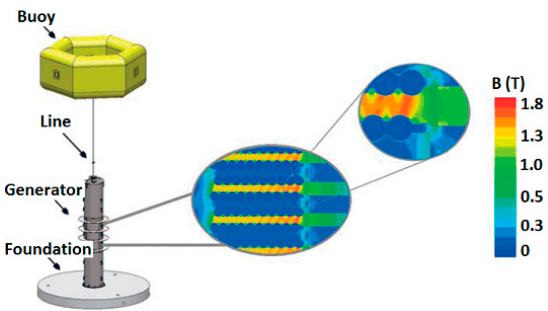
Figure 3. A rough sketch of the magnetic field in the WEC.